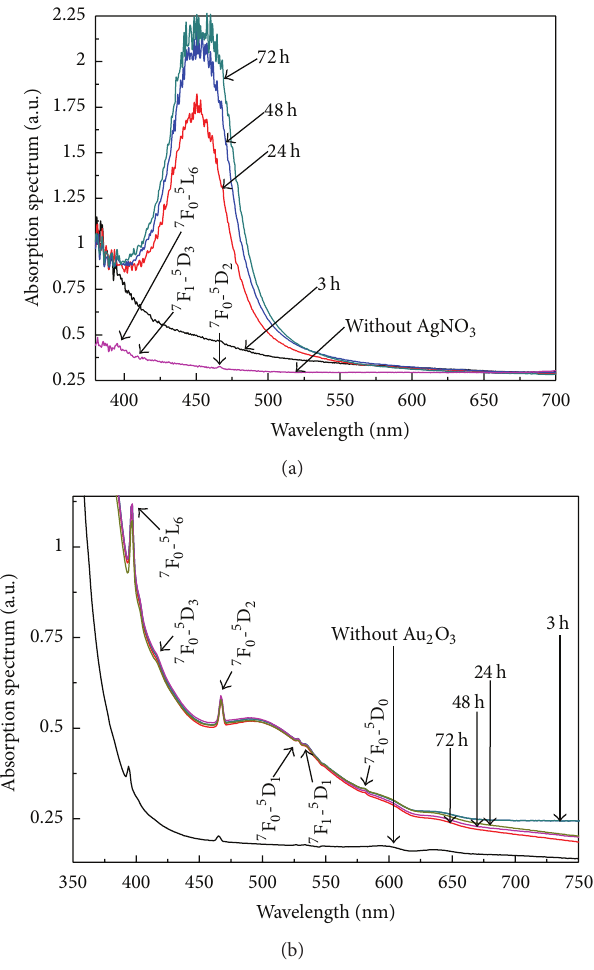
Figure 1: Absorption spectra of the Eu 3+ doped samples heat- treated during different times. (a) PGO-Eu:Ag. (b) BGO-Eu:Au. Also presented are the spectra of both glasses without metallic NPs [1].